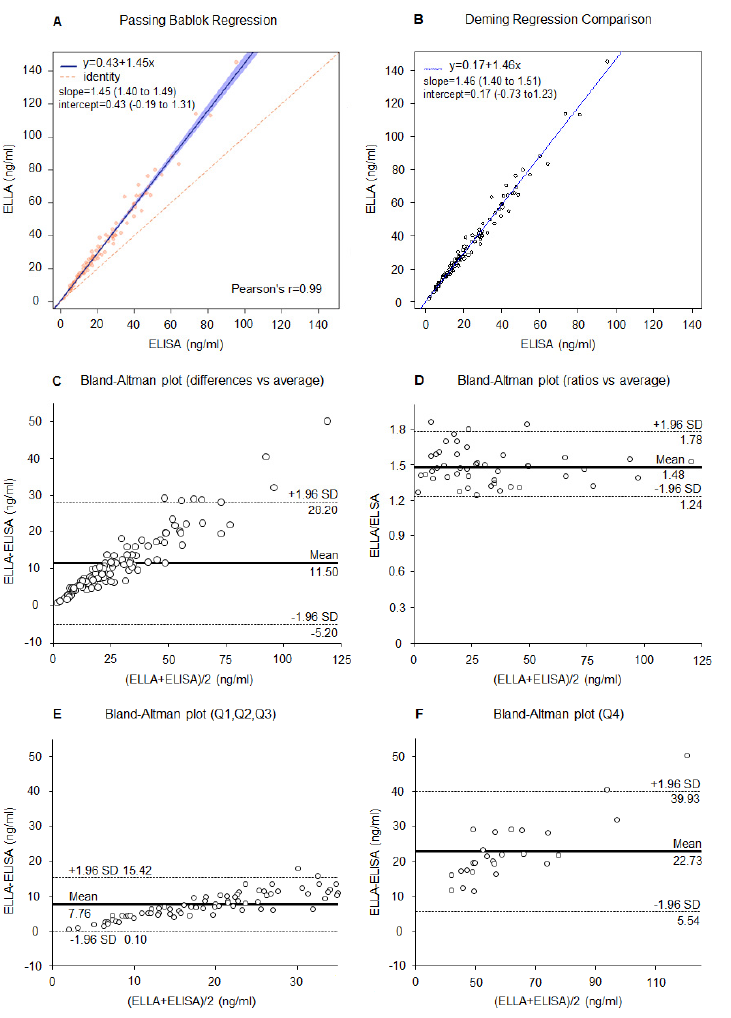
Figure 3. Correlation between ELLA and ELISA for leptin measurement ( n = 104). ( A ) Passing– Bablok and Pearson’s r coefficient, ( B ) Deming regression, ( C ) Bland–Altman plot (differences vs. average), ( D ) Bland–Altman plot (ratio vs. average), ( E ) Bland–Altman plot (differences vs. average) for leptin < 33 ng/mL (<third quartile, Q1-2-3), and ( F ) for leptin ≥ 33 ng/mL ( ≥ third quartile, Q4). Dashed lines represent 95%